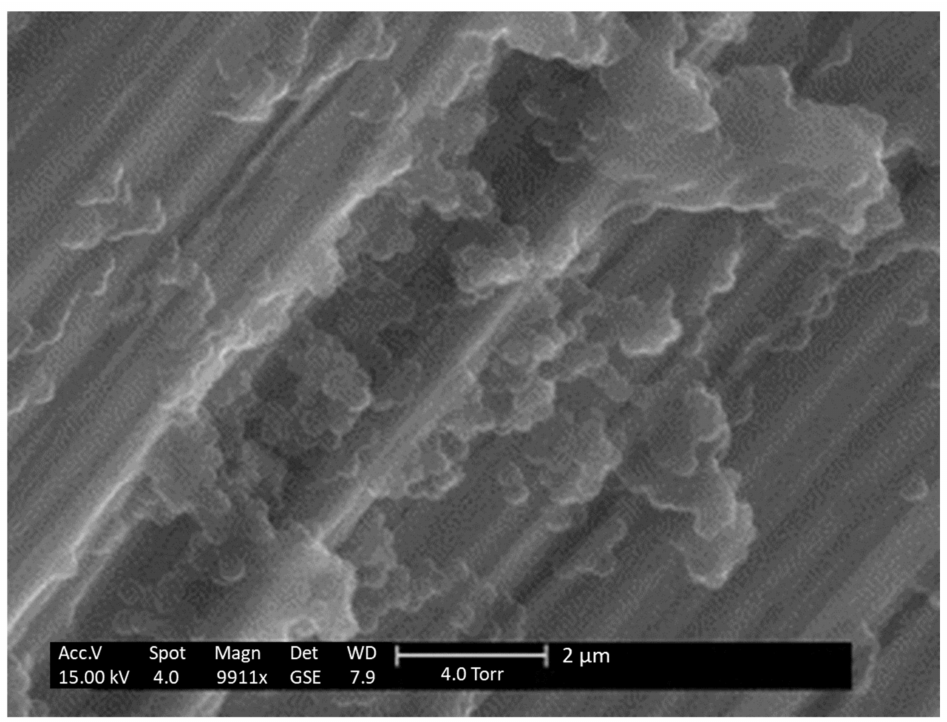
Figure 9. ESEM imaging of freeze-dried purified PCL NC after reconstitution prepared with 5% ( w/v ) of HP β CD as cryoprotectant. Adapted with permission from ref. [51]. 2021,